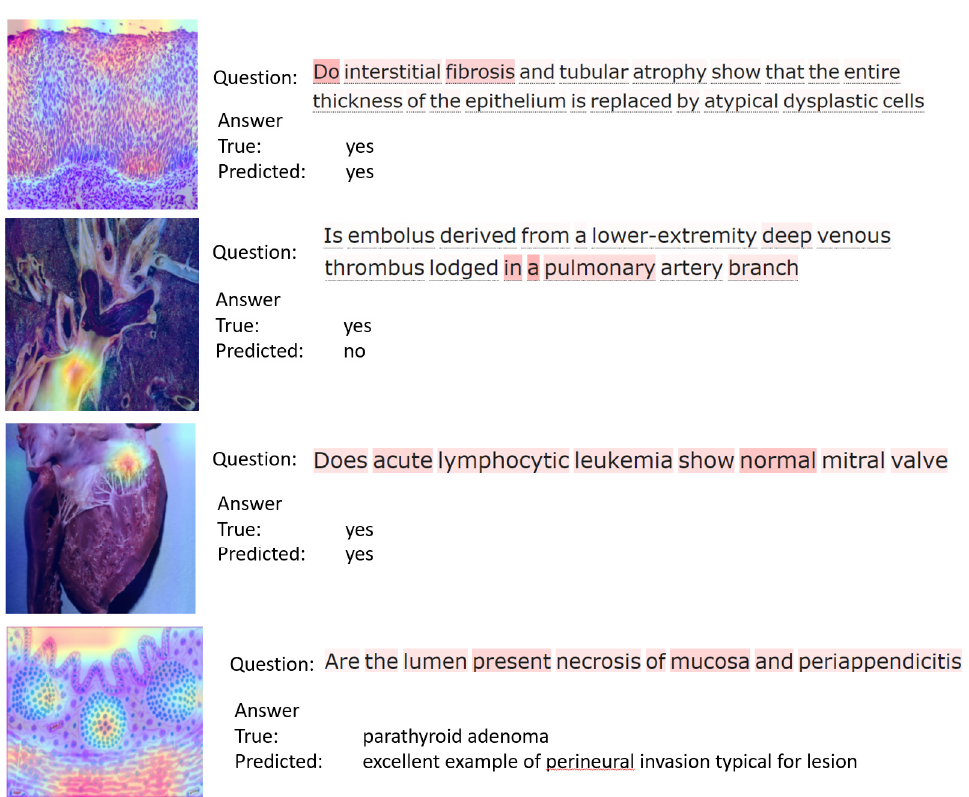
Figure 8. Attention maps obtained for sample images from PathVQA dataset.